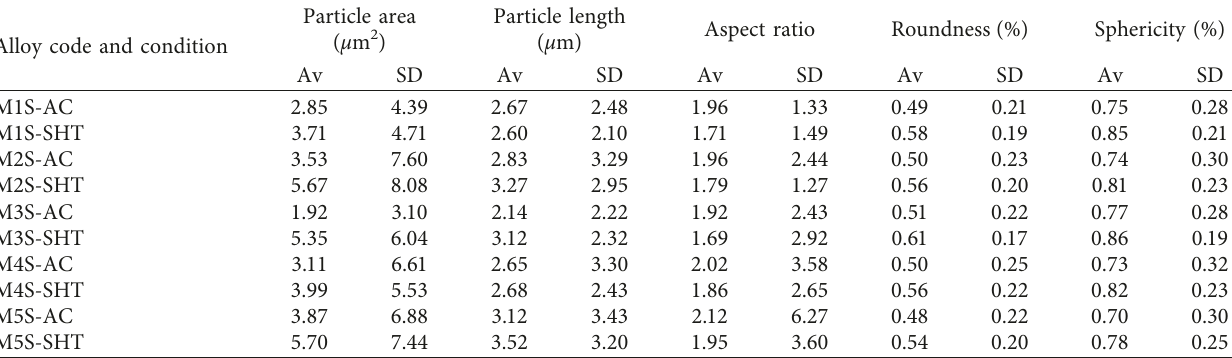
Table 4: Characteristics of eutectic silicon particles in as-cast and solution heat-treated conditions of the alloys studied. Alloy code and